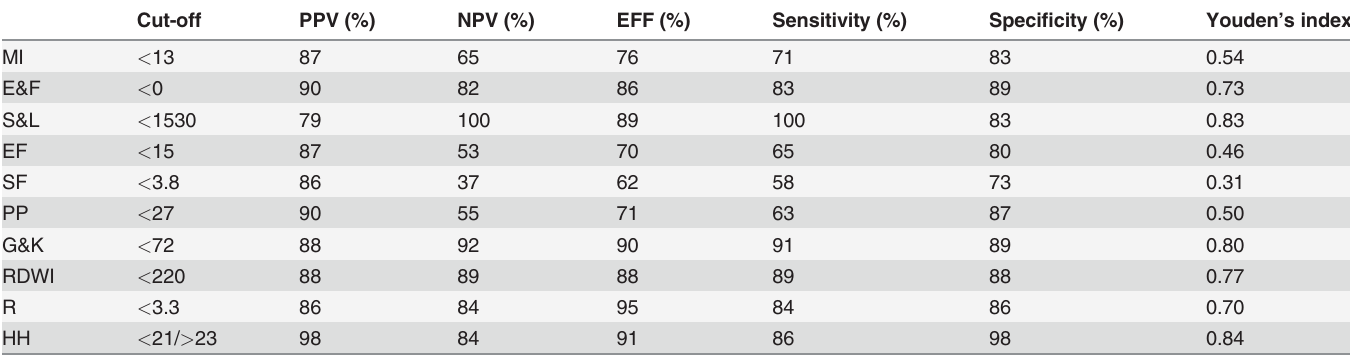
Table 3. The evaluation of different discrimination index in differentiation of α -thalassemia minor from IDA according to the previously published standard cut-off values.